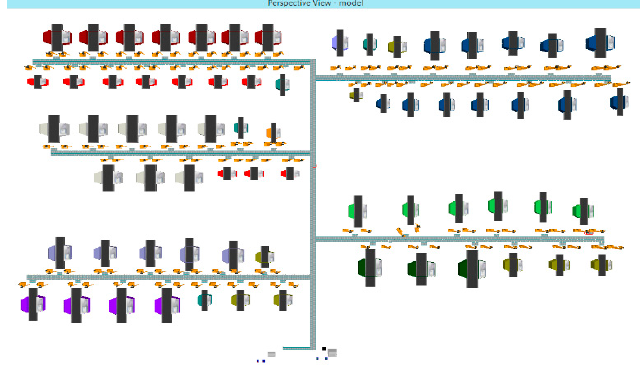
Figure 13. The simulation model.